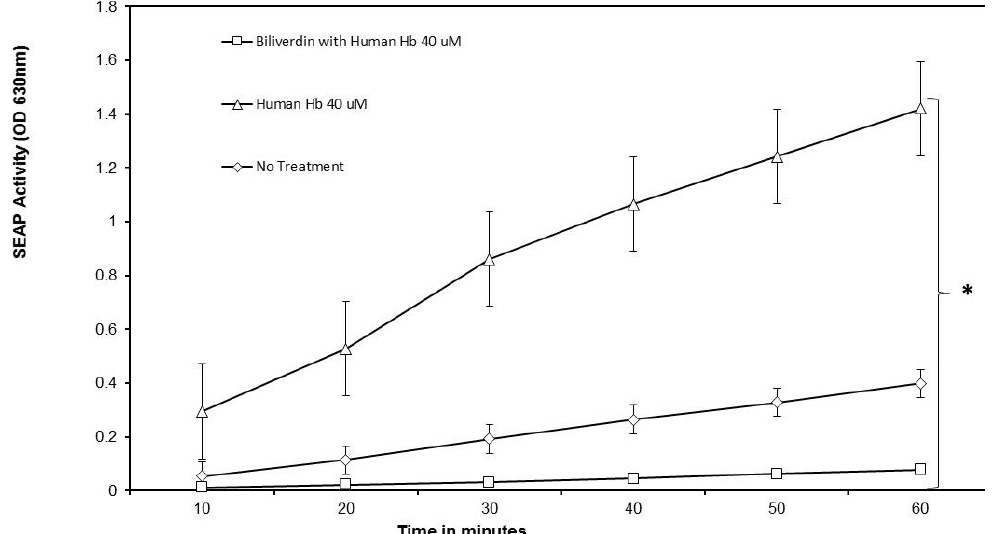
Figure 8. Kinetic evaluation of SEAP activity in culture supernatants derived from Hb-treated HEK hTLR4 cells. Cells were cultured at an initial density of 1 × 10 5 cells/well and treated with 40 μM Hb (Triangles), 40 μ M Hb plus 40 μ M Bv (squares), or complete medium with FCS (diamonds). All Bv and Hb dilutions were made in complete medium plus FCS. SEAP was tested using QuantiBlue substrate (InvivoGen). The data are presented in kinetic format, wherein OD 630 nm was measured in reaction wells every 10 min. A kinetic analysis was performed to show any changes that might occur in both total SEAP activity and enzymatic rates (Hb slope = 0.040, R 2 = 0.98; Hb + Bv slope = 0.007, R 2 = 0.99; No Treatment slope = 0.0016, R 2 = 0.98). Bv treatment only was shown in Figure 5 to have little or no effect on baseline SEAP and is not reiterated here. Significance between lines is shown with a bracket and an asterisk (*) designating p < 0.05 and was based upon the ANOVA results between the regression lines for Hb treatment only and Hb + Bv treatment.